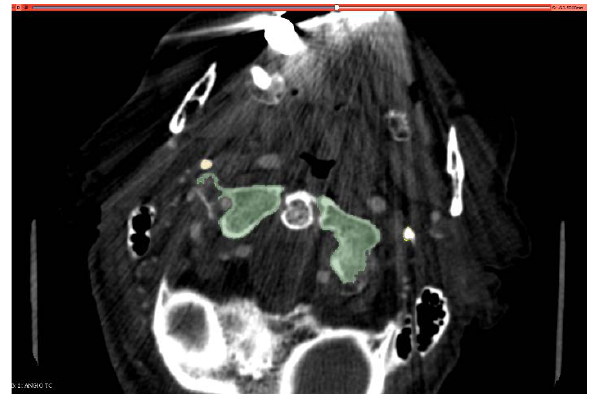
Figure 1. CTA segmentation using threshold selector.